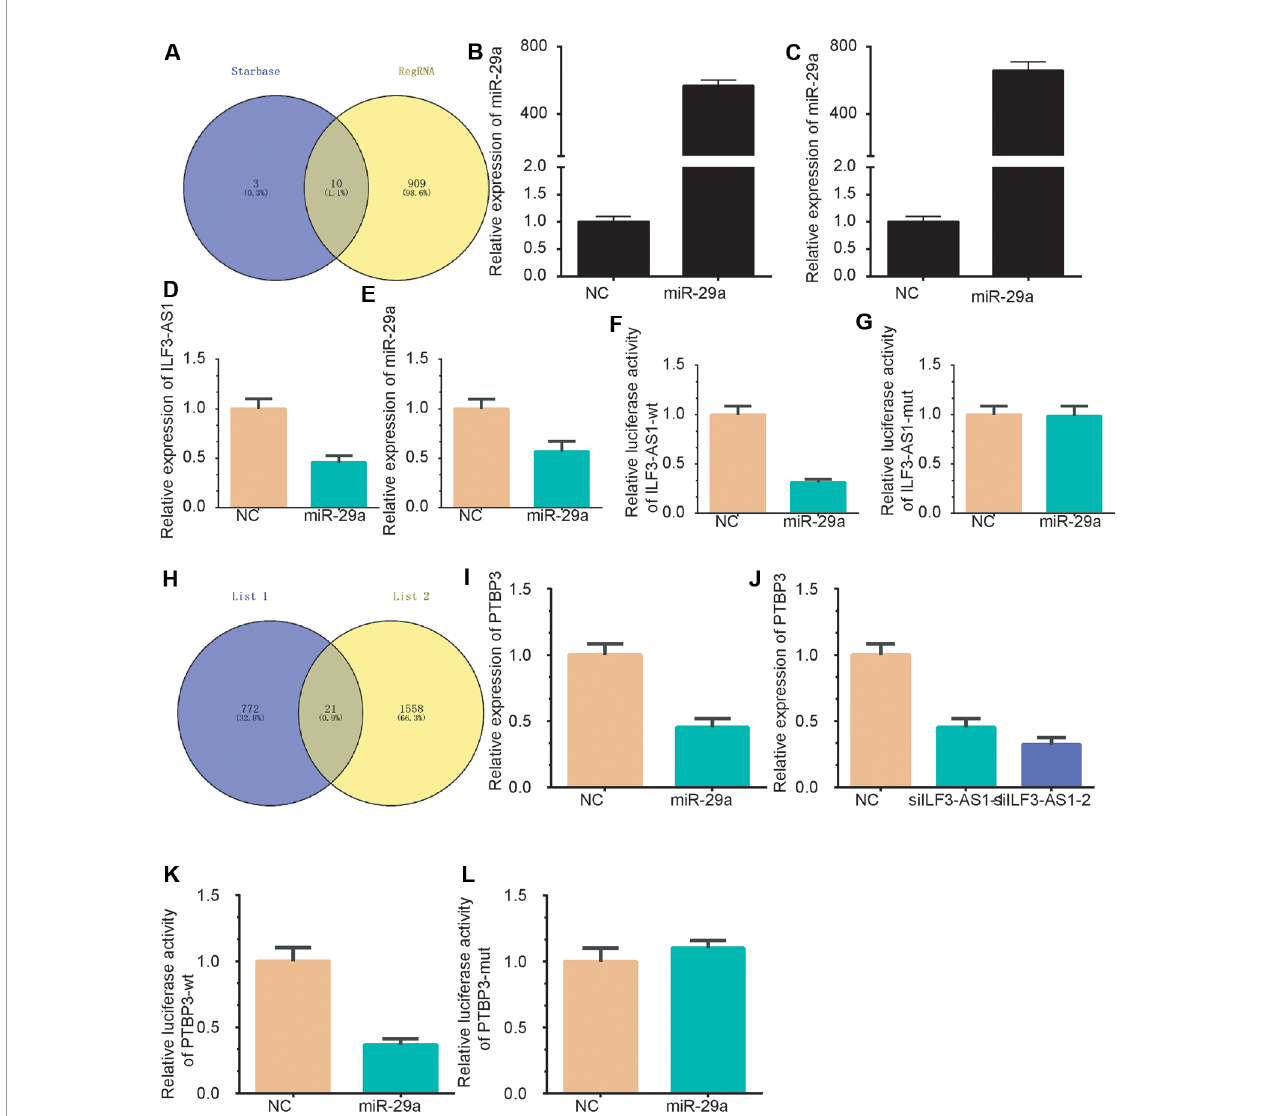
FIGURE 8 | ILF3-AS1 Binds with miR-29a to promote PTBP3 expression. (A) A Venn plot was performed to identify the potential targeting miRNAs of ILF3-AS1 using RegRNA database and Starbase database. (B-C) miR-29a levels were up-regulated in AGS (B) and SGC-7901 (C) cells after transfecting with miR-29a mimics. (D, E) miR-29a overexpression down-regulated ILF3-AS1 expression in AGS (D) and SGC-7901 (E) cells. (F, G) Luciferase reporter assay showed that miR- 29a signi fi cantly inhibited the luciferase activity of ILF3-AS1-wt reporter (F) , not ILF3-AS1-mutated reporter (G) . (H) A Venn plot was performed to identify the potential targets of ILF3-AS1 and miR-29a. (I, J) overexpression of miR-29a (I) or knockdown of ILF3-AS1 (J) signi fi cantly down-regulated the expression levels of PTBP3. (K, L) Furthermore, a dual-luciferase reporter gene assay con fi rmed that miR-29a could signi fi cantly inhibit luciferase activity of PTBP3-3'UTR mutated reporter (K) , whereas miR-29a could not signi fi cantly inhibit luciferase activity of PTBP3-3'UTR mutated reporter (L)